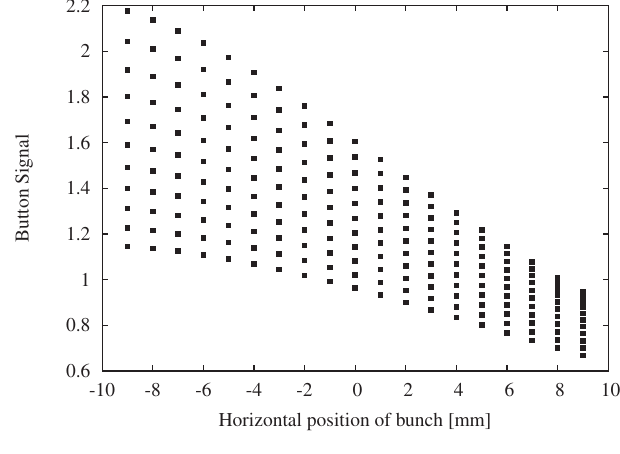
FIG. 2. Button signals from 209 orbits on a 18 mm (cid:5) 10 mm grid.